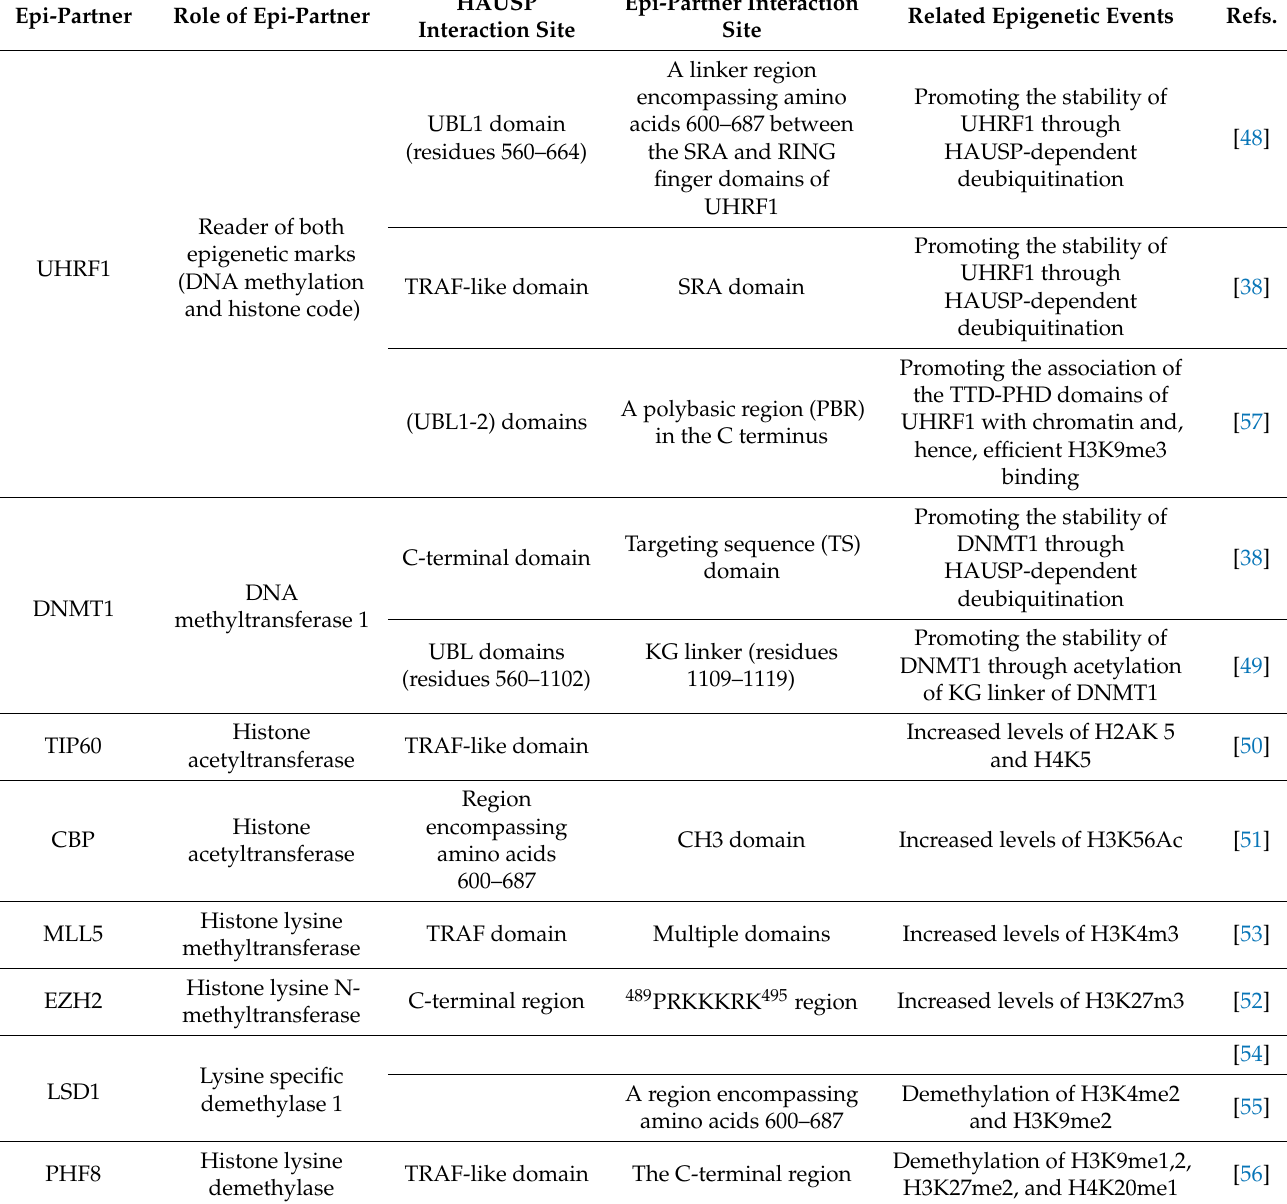
Table 1. Role of HAUSP in the regulation of epigenetic players and related